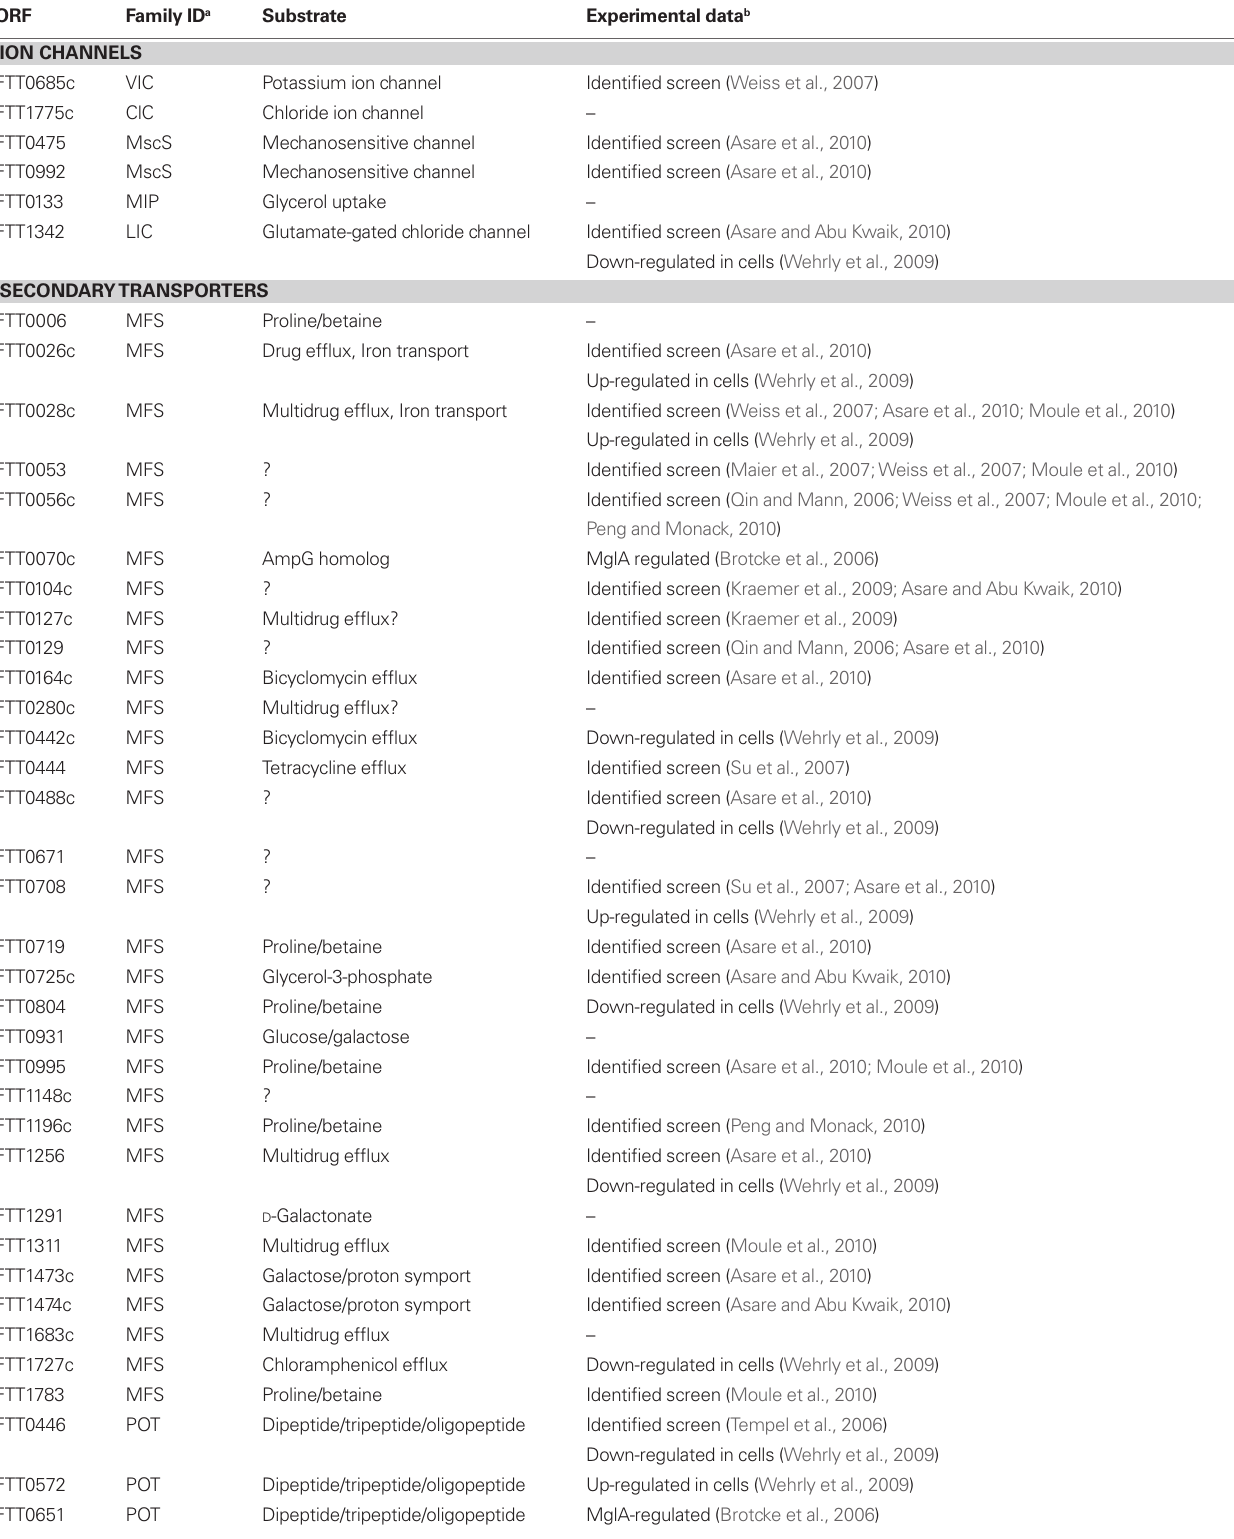
Table 2 | The transport systems of F. tularensis